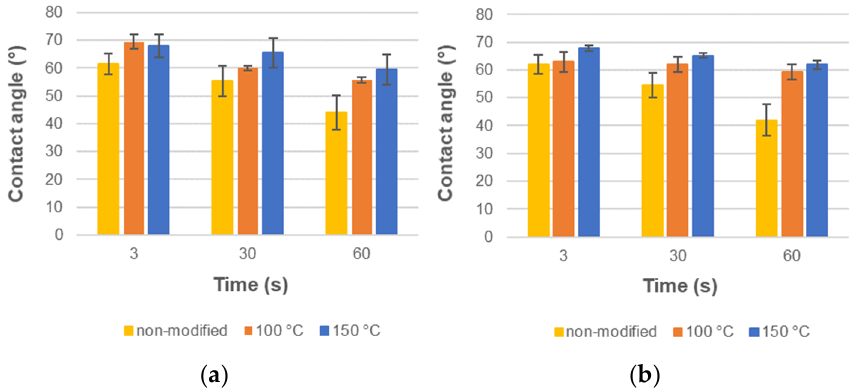
Figure 4. Contact angle of ( a ) iroko and ( b ) tauari wood before and after thermo-mechanical treat- ment.